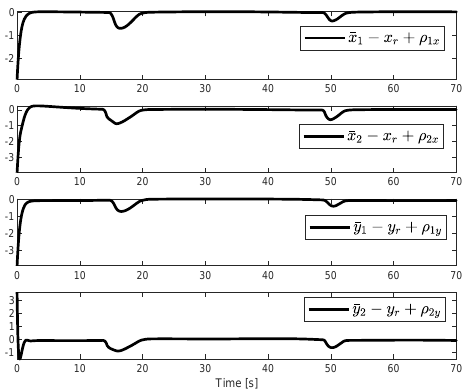
Figure 10. The tracking errors in the X and Y directions corresponding to the two followers while considering obstacle avoidance.